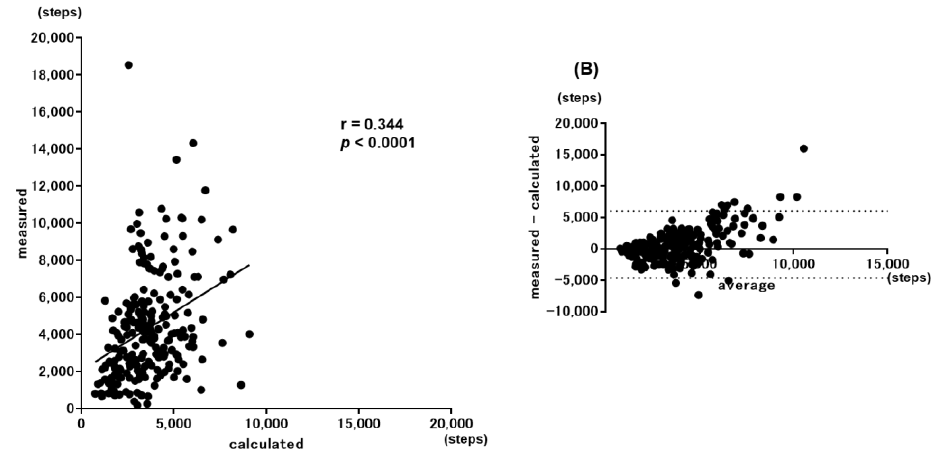
Figure 3. Correlations between the measured values and calculated values by the simple equation. ( A ) Scatter plot and ( B ) Bland – Altman plot.